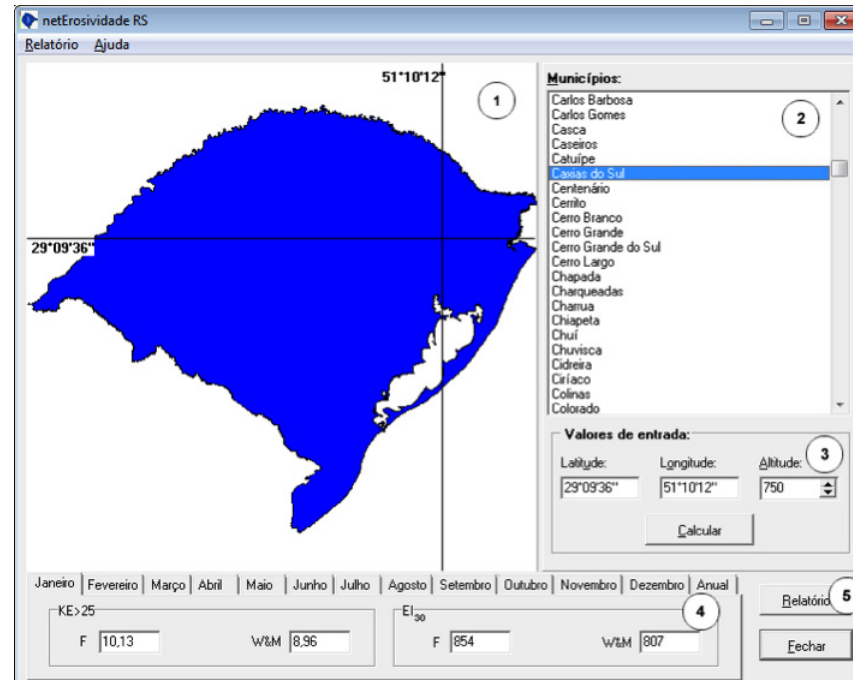
Figure 1. NetErosividade RS main